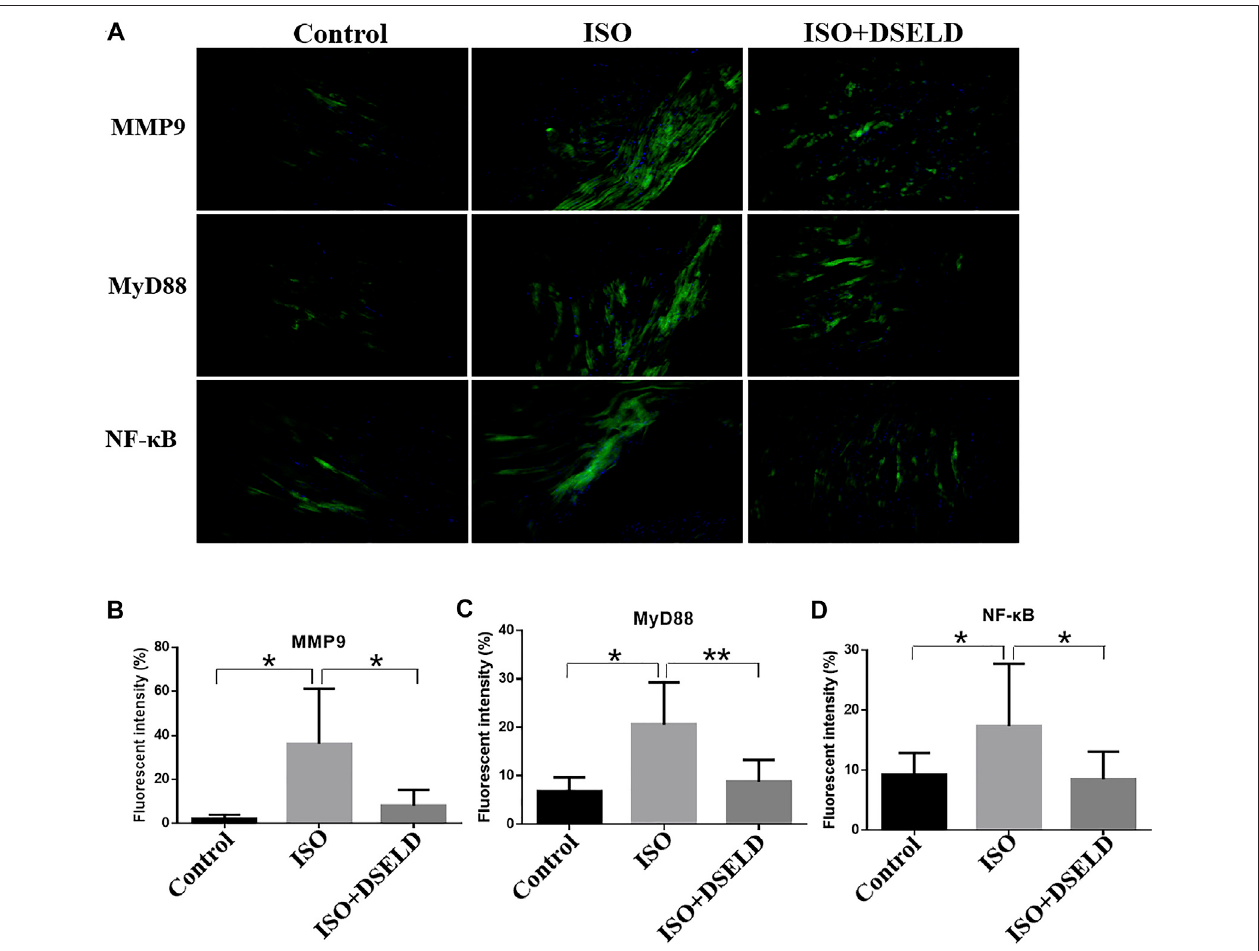
FIGURE 7 | Dangshen Erling decoction (DSELD) attenuates cardiac in fl ammation by inhibiting the expression of members in the Toll-like receptor (TLR)4 signaling pathway in the cardiac tissue. (A) Representative immuno fl uorescence images of the heart samples from different treatment groups [green: matrix metalloproteinase (MMP)9, myeloid differentiation factor (MyD)88, and nuclear factor (NF)- κ B proteins; blue: DAPI, × 200]. (B – D) Quanti fi cation of the relative fl uorescence intensity from different groups of mice, n (cid:1) 4. *p < 0.05, **p < 0.01.